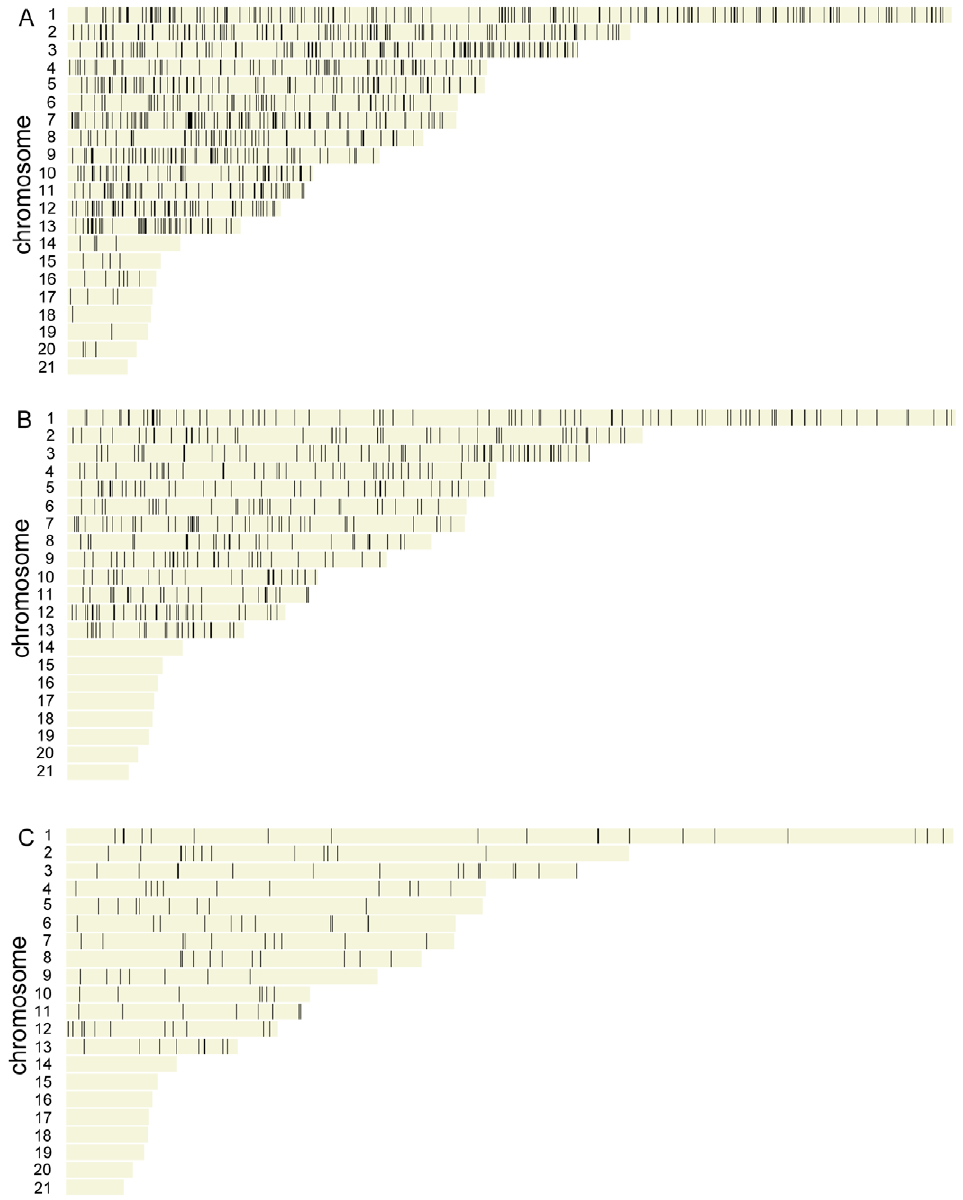
Figure 2. The genes predicted to code for the secretome of M.graminicola displayed over the 21 chromosomes. ( A ) The total 970 genes arising from stage 1 of the analysis. ( B ) The refined 492 genes arising from stage 2 of the analysis. ( C ) The 85 genes found so far to be M. graminicola specific.